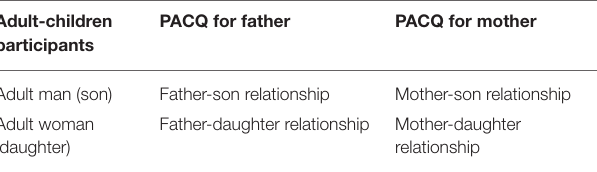
TABLE 2 | PACQ for parent adult-children